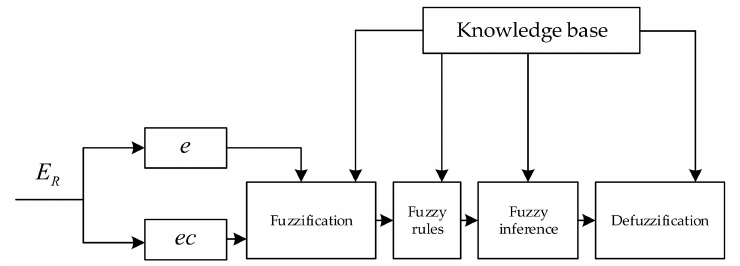
Figure 7. Fuzzy controller